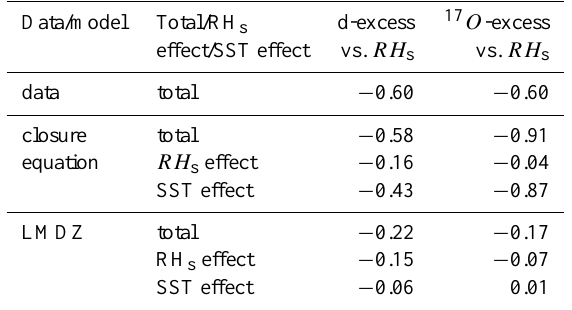
Table 4. Slopes of d-excess and 17 O -excess as a function of RH s . For the data, the slopes correspond to the regression lines shown in red in Fig. 1e, f. For LMDZ and the Merlivat and Jouzel (1979) clo- sure equation, the “total” slope corresponds to the regression lines shown in blue and green in Fig. 1e, f. The “RH s effect” is calcu- lated by the difference between the “total” slope and the slope that we would obtain if RH s was set to 60% everywhere (RH s cste sim- ulation for LMDZ). The “SST effect” is calculated by the difference between the slope that we would obtain if RH s was set to 60% ev- erywhere, and the slope that we would obtain if RH s was set to 60% everywhere and if SST was set to 15 ◦ C everywhere (RH s SSTcste simulation for